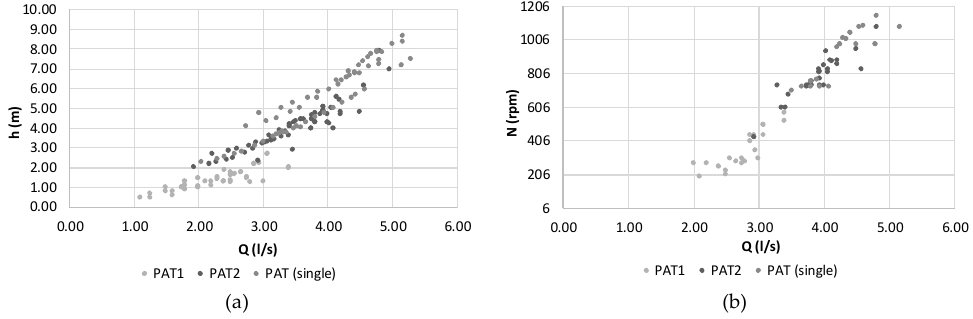
Figure 3. PATs’ characteristic operating points when working in parallel and in a single mode: ( a ) h curve; ( b ) N curve.